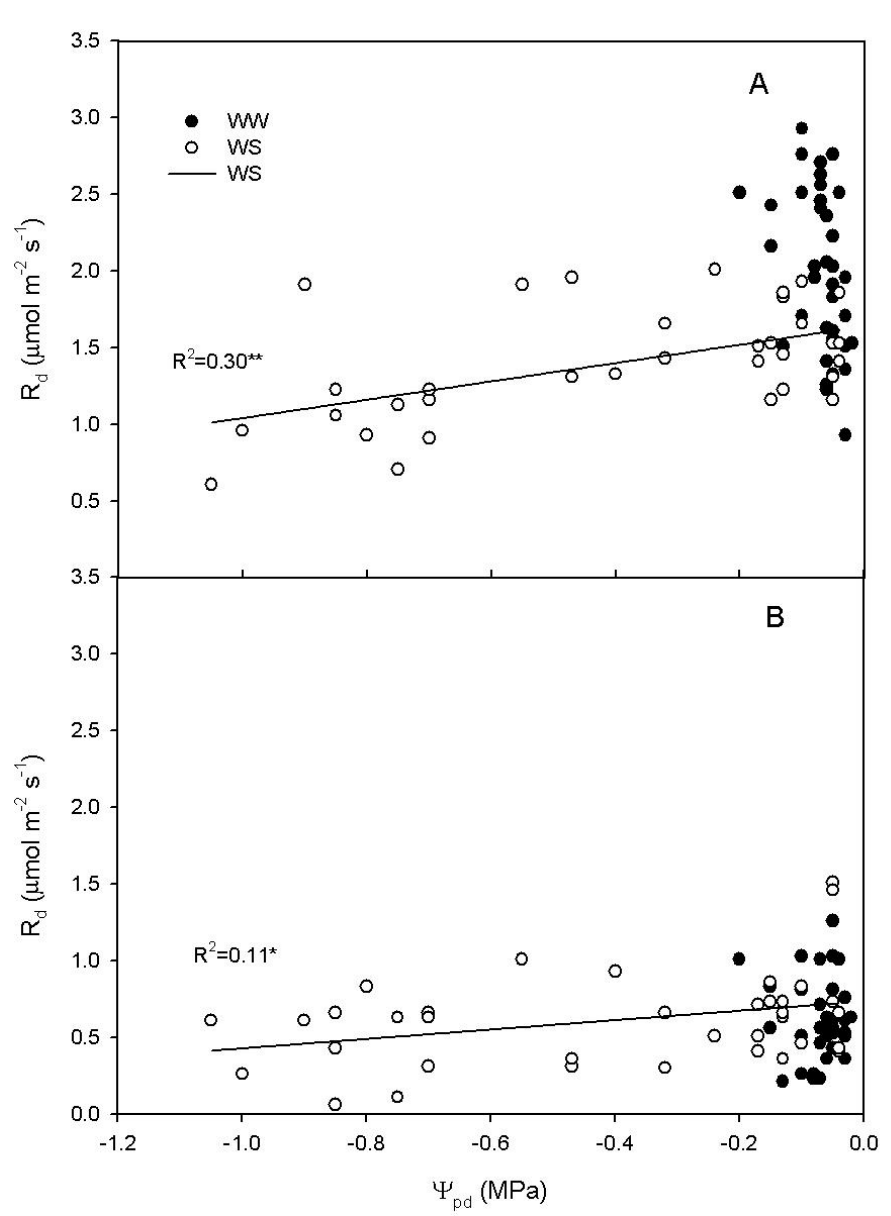
Figure 6. Relationship between leaf dark respiration (R d ) and pre-dawn water potential ( Ψ pd ) in water stressed (WS) vines at ( A ) midday (y = 1.64 + 0.59x, R 2 = 0.30 p < 0.0001) and ( B ) at 4:00 a.m. (y = 0.73 + 0.31x, R 2 = 0.11 p = 0.04) during water stress from DOY 181 to DOY 187. * indicates p < 0.05; ** indicates p < 0.0001. In the WS treatment, a relation between leaf NSC at midday and Ψ pd was described by a linear regression (R 2 = 0.59, p < 0.001) (Figure 7A), and reported between leaf NSC at 4:00 a.m. and Ψ pd (R 2 = 0.17, p = 0.011) (Figure 7B).